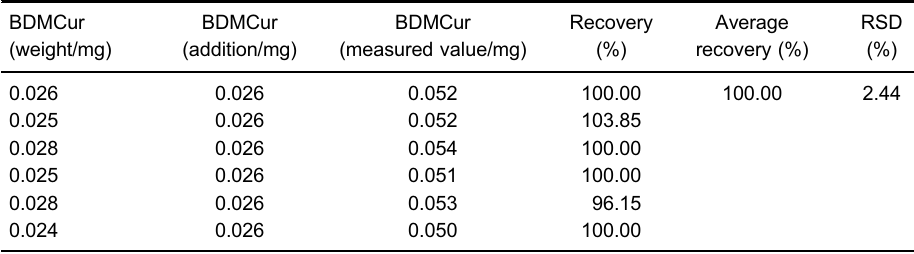
Table 2. Bisdemethoxycurcumin (BDMCur) sample recovery rate test results.